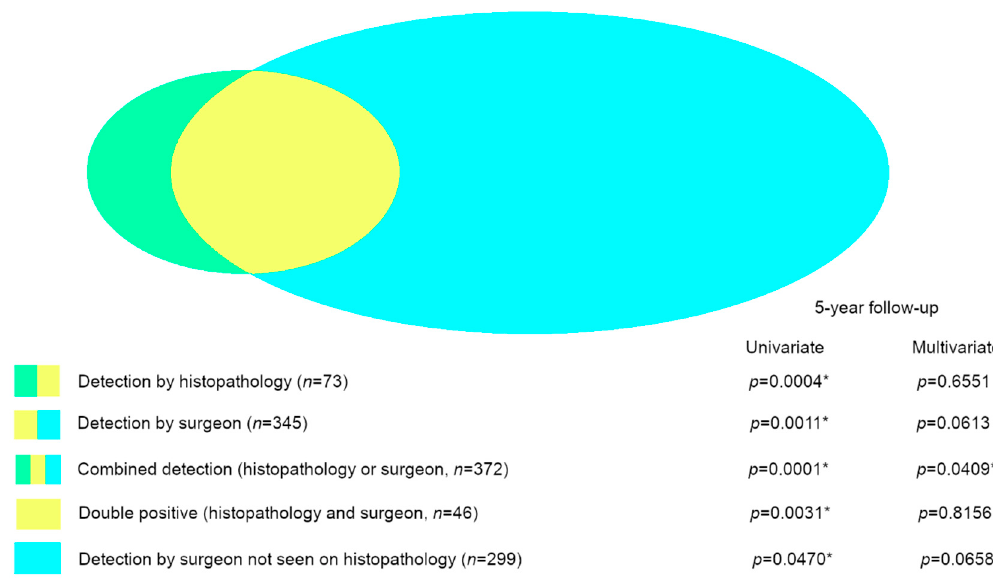
Figure 2. Graphical depiction of the different subgroups of primary meningiomas with CNS invasion that were analyzed. The color represents the mode of assessment: histopathology (green and yellow), intraoperative (yellow and blue), combined histopathology and intraoperative (green, yellow and blue), double positive by histopathology and intraoperative (yellow), only positive by intraoperative assessment (blue). All subgroups were significant factors for tumor recurrence in the univariate analysis, but only the combined assessment (histopathology and intraoperative) turned out to be an independent significant prognostic factor in the multivariate analysis (asterisk (*): statistically significant result).